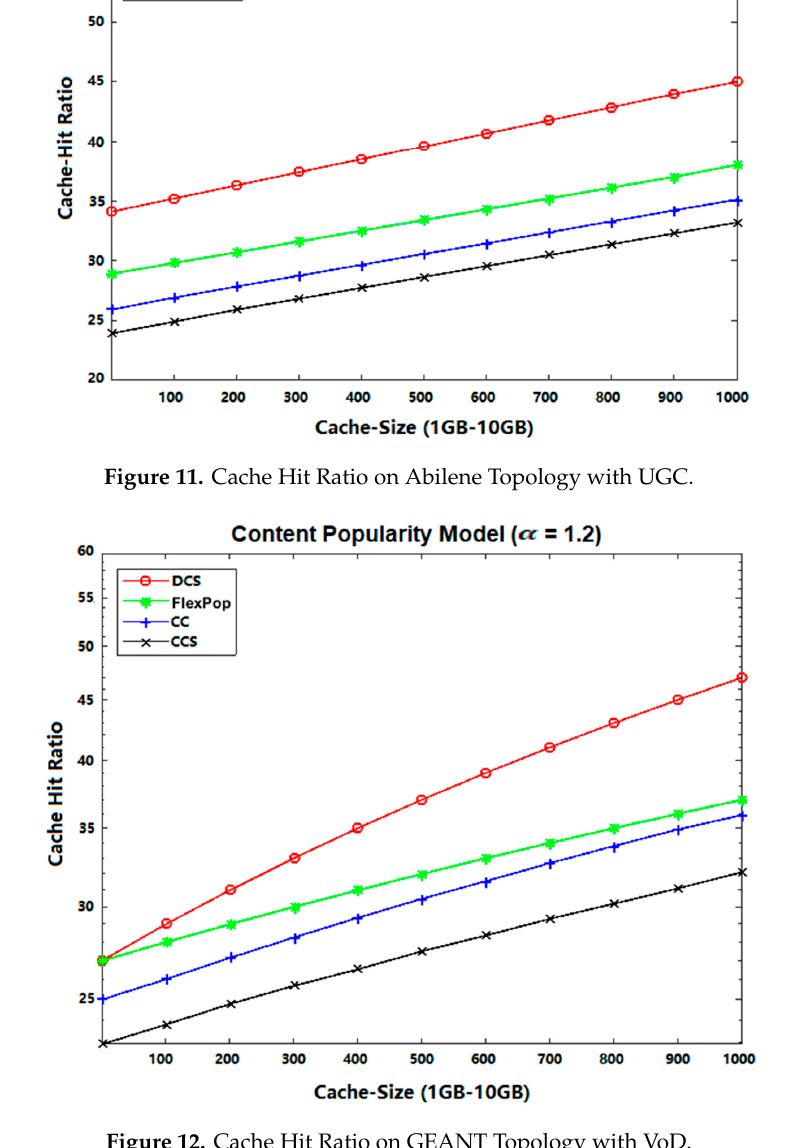
Figure 12. Cache Hit Ratio on GEANT Topology with VoD.